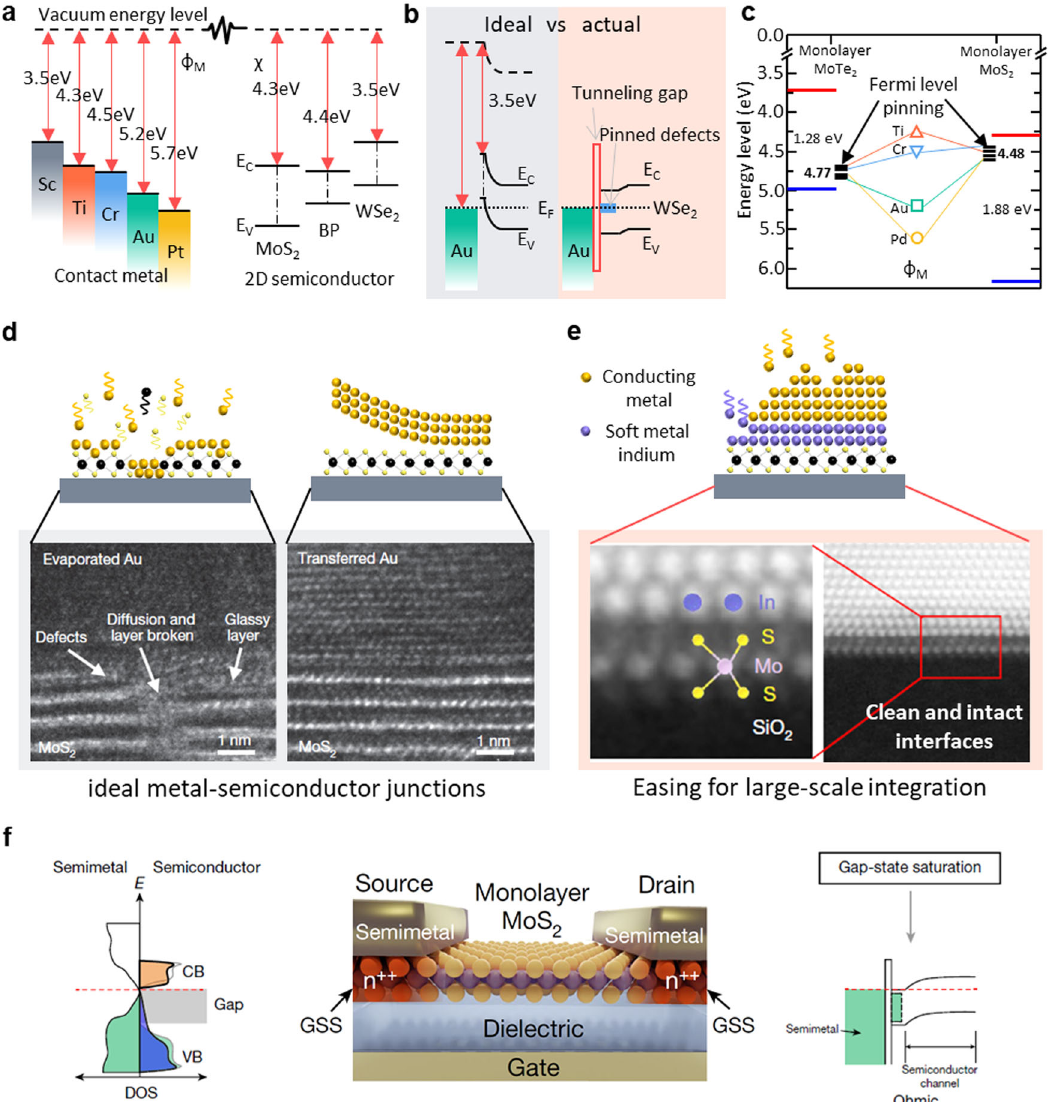
Fig. 4 Contact characteristics of 2D semiconductors. a The band alignment of common metals (Sc, Ti, Cr, Au, and Pt) with examples of monolayer 2D semiconductors (MoS 2 , BP, and WSe 2 ). b Comparison of ideal and practical band structures of metal-2D semiconductor (Au-WSe 2 ) contacts. c Fermi level pinning effect for monolayer MoS 2 and MoTe 2 . c are reproduced from ref. 59 . d Illustration of transferred metal technique to forming ideal metal-semiconductor junctions. The upper and lower panel show the Cross-sectional schematics and TEM images between evaporated metal and transferred metal, respectively. d are reproduced from ref. 64 . e Illustration of ultraclean vdW contact by evaporating indium as a capping layer. The lower panel shows atomic-resolution images of In/Au on monolayer MoS 2 . e are reproduced from ref. 65 . f Illustration of ultralow contact resistance on 2D semiconductors via semimetal. The left and right panels show the density of state (DOS) and the band diagram of semimetal and semiconductor contact respectively. The middle panel shows the Schematic of a transistor with a monolayer MoS 2 channel and semimetal contacts. c are reproduced from ref. 36